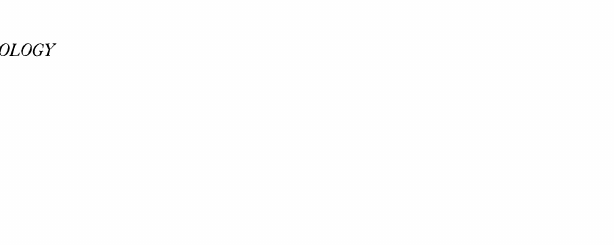
TABLE 6. Maternal infection All